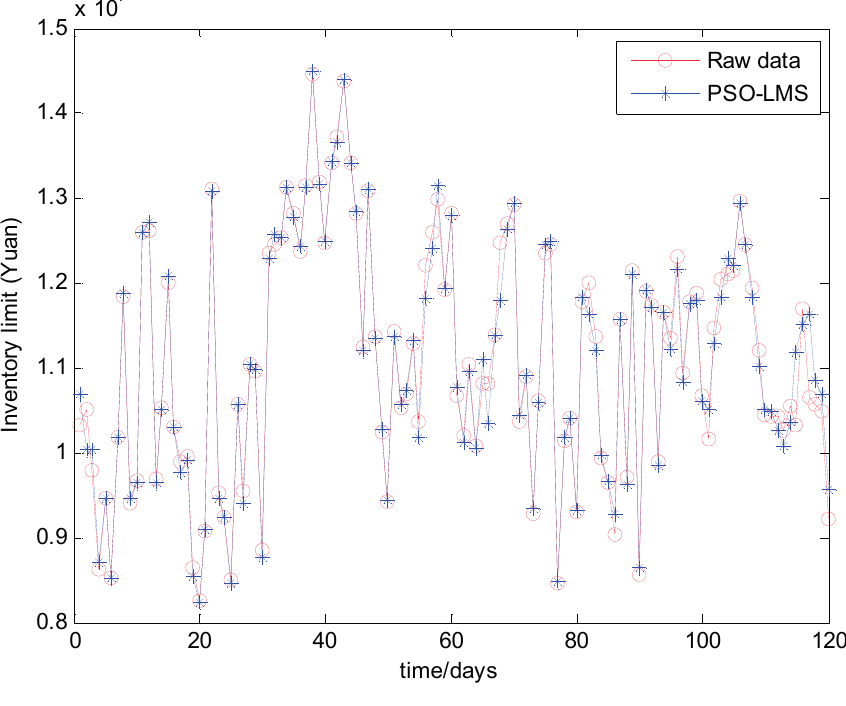
Figure 9. Prediction results based on PSO-LMS algorithm.